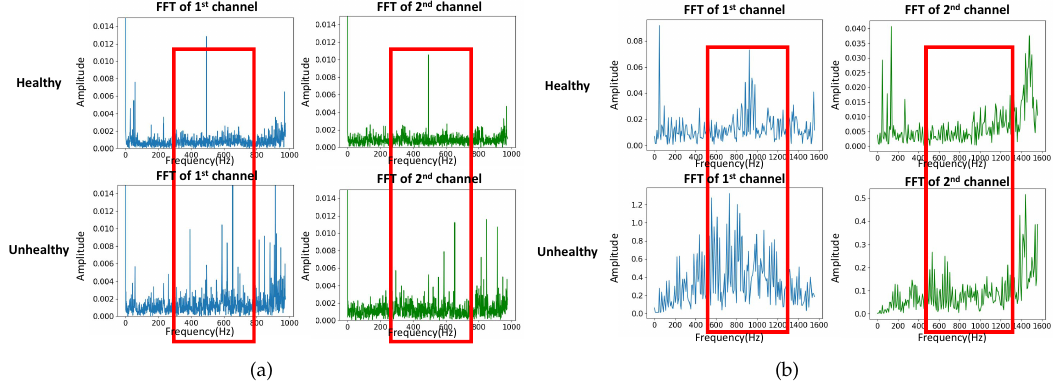
TABLE II BIC FOR HMM M ODELING